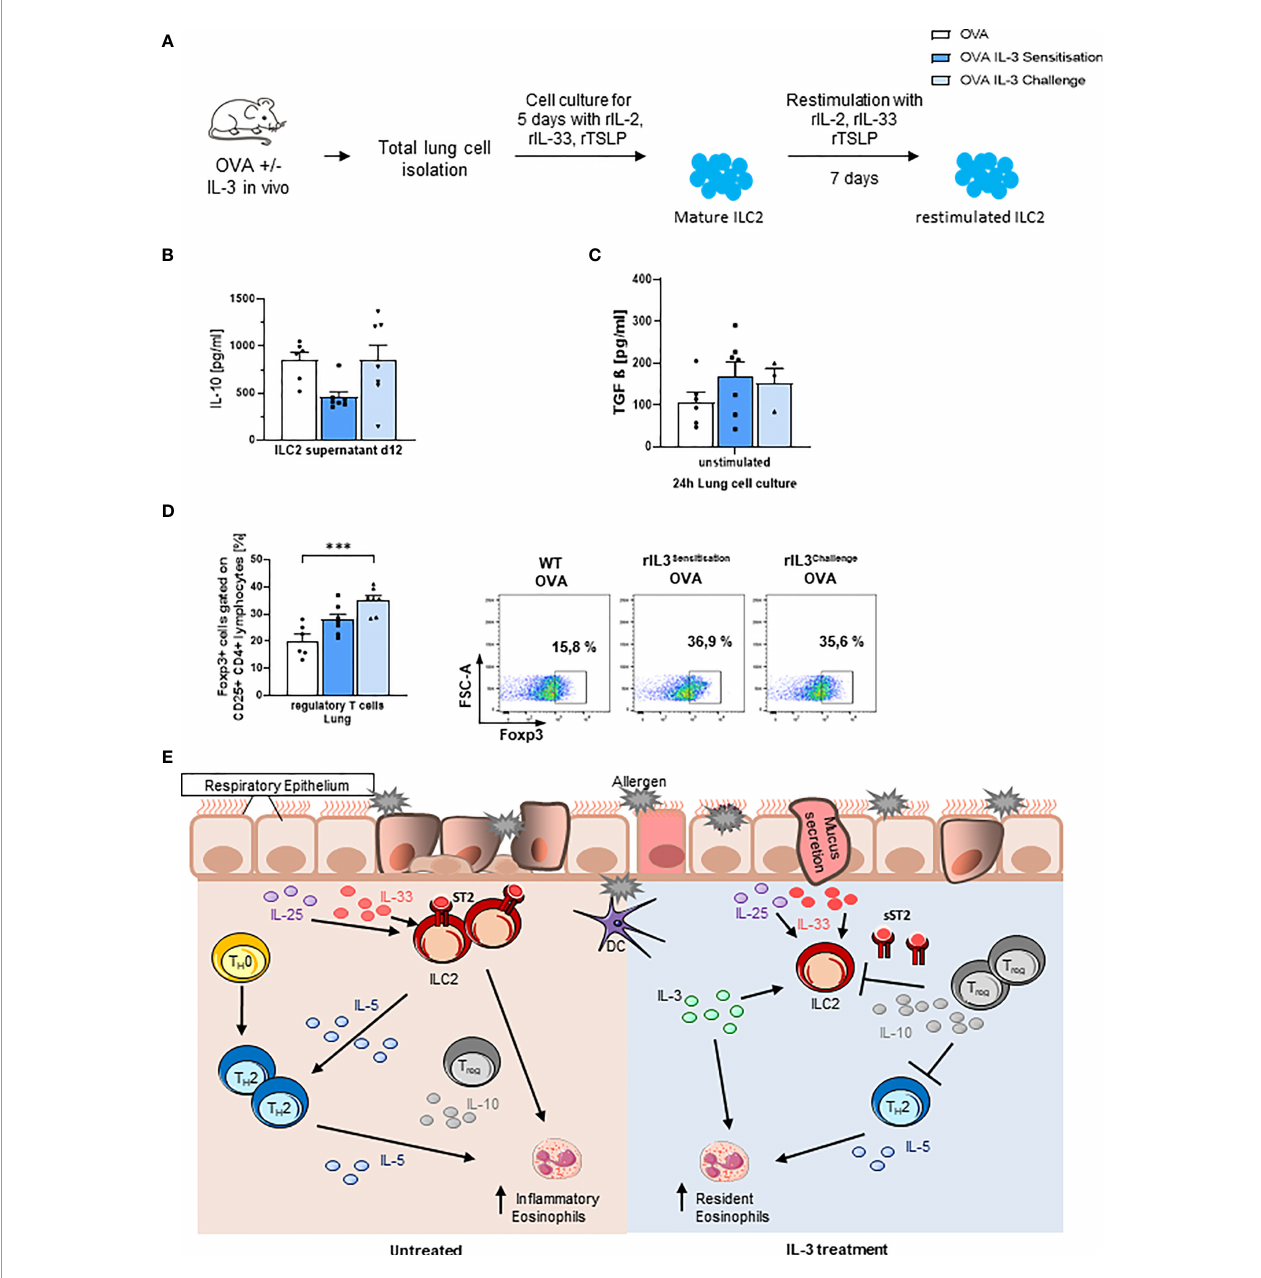
FIGURE 4 | Intranasal rIL-3 application during challenge induces Treg cells. (A) Experimental design for lung ILC2 skewing. (B) After 5 days of in vitro ILC2 differentiation, IL-10 release was measured in the supernatants of ILC2 skewed from the lung of wild-type (WT) asthmatic mice with and without additional rIL-3 treatment during sensitization or challenge phase (n = 6/7/7). (C) TGF-beta level in 24-h unstimulated lung cell culture, measured by ELISA (n = 6/7/4). (D) Flow cytometry analysis of Foxp3+CD25+CD4+ regulatory T cells in total lung cells. A representative dot plot is shown for each group (n = 6/7/7). (E) Summary of the immunoregulatory role of IL-3 in allergic asthma. Data are presented as means ± SEMs. One-way ANOVA or Kruskal – Wallis test was used to calculate statistical signi fi cance. ***p ≤